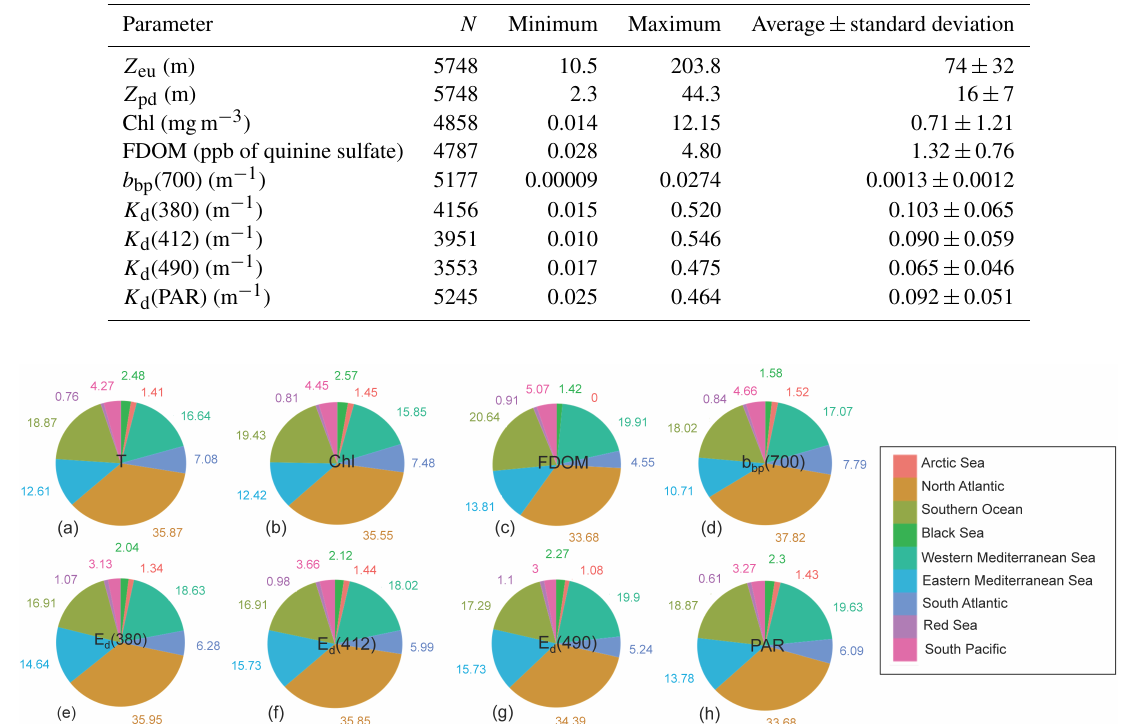
Table 1. Number of profiles and minimum, maximum, and average ( ± standard deviation) values for each variable included in the Biogeochemical-Argo database within the first optical depth (BOPAD-surf).